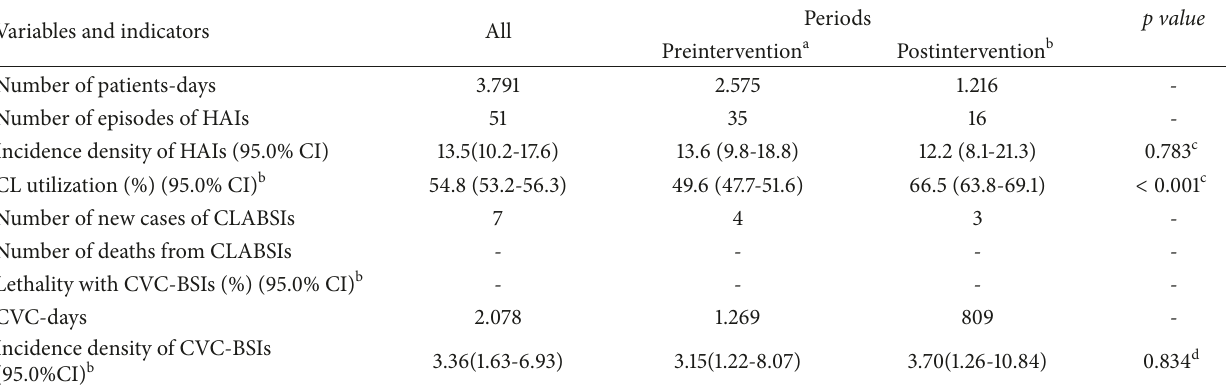
Table 3: Evaluated variables and indicators in the pediatric ICU. Central Brazil.